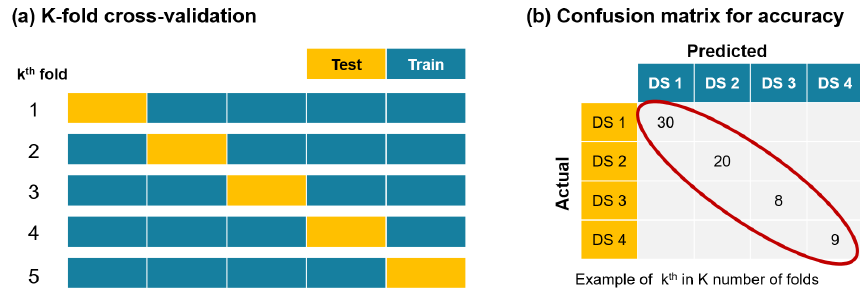
Figure 6. (a) An example of a five-fold cross-validation technique for the purpose of illustration. The same dataset can be folded into five equal sizes: one fold is held out for testing, and the remaining four folds are used to develop a training model to predict the accuracy of the training model. This is repeated five times, with accuracies being tabulated in each iteration. (b) An accuracy table (confusion matrix) is produced in each iteration of the k folds. The sum of the diagonal in the table is divided by the sum of observations to get the percentage of accuracy in the k th fold. Table 3. Components of an ordinal logistic regression